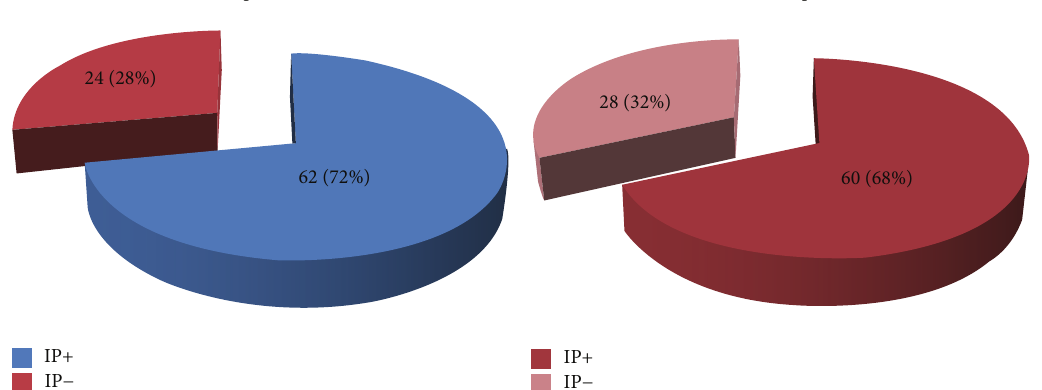
Figure 1: Pie charts showing the number and percentage of patients with and without diabetes who demonstrated ischemic preconditioning (IP). Extracted from [40].